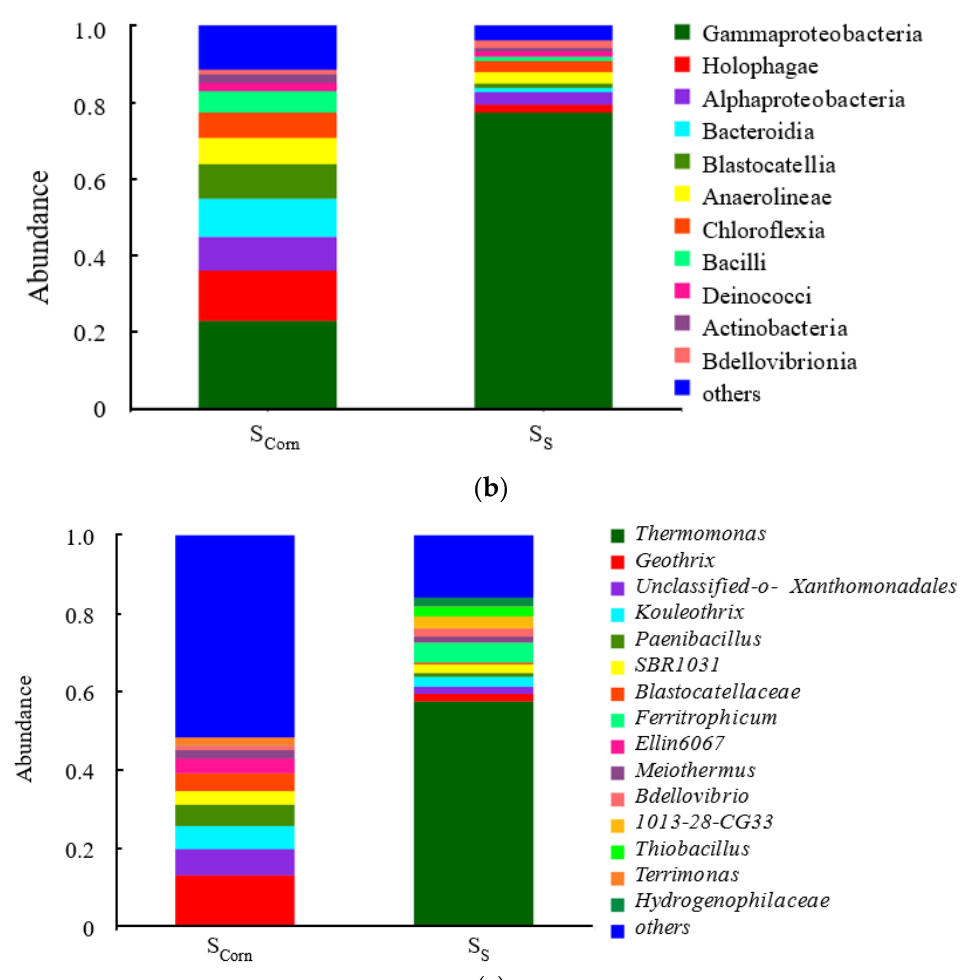
Figure 5. The species of sludge samples from corncobs and S 0 particles ( a ) at phylum level, ( b ) at class level, ( c ) at genus level (S corn presents sludge obtained from corncob surface, S s presents sludge obtained from sulfur surface, S 0 presents activated sludge).